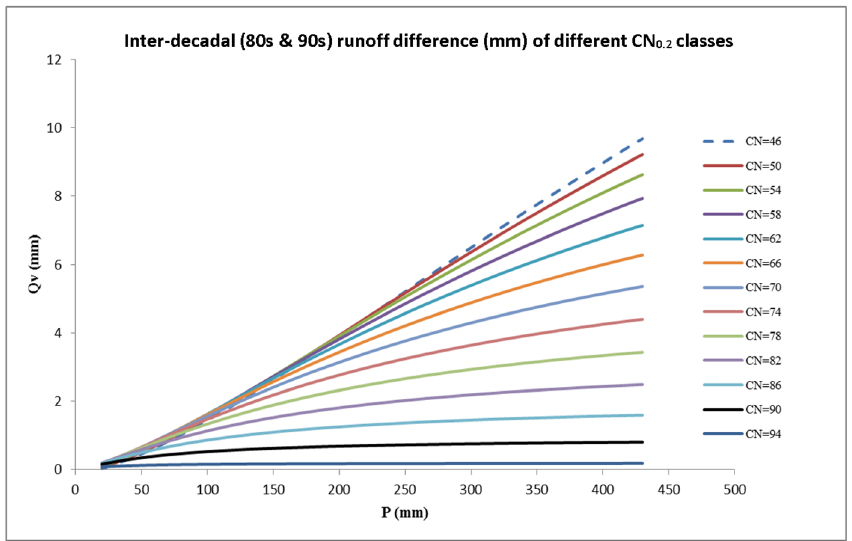
Figure 3. Decadal runoff difference of Equations (10) and (11) for selected CN 0.2 values to reflect the